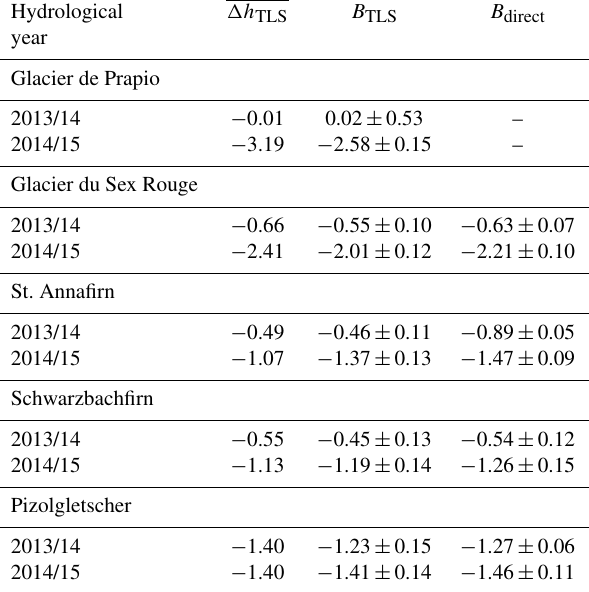
Table 4. Glacier-wide mean of TLS-derived surface elevation changes ( (cid:49)h TLS ) (in m) as well as specific geodetic ( B TLS ) and di- rect glaciological ( B direct ) annual mass balance variables with cor- responding uncertainties (in mw.e.) for Glacier de Prapio, Glacier du Sex Rouge, St. Annafirn, Schwarzbachfirn, and Pizolgletscher, and the two observation periods 2013/14 and